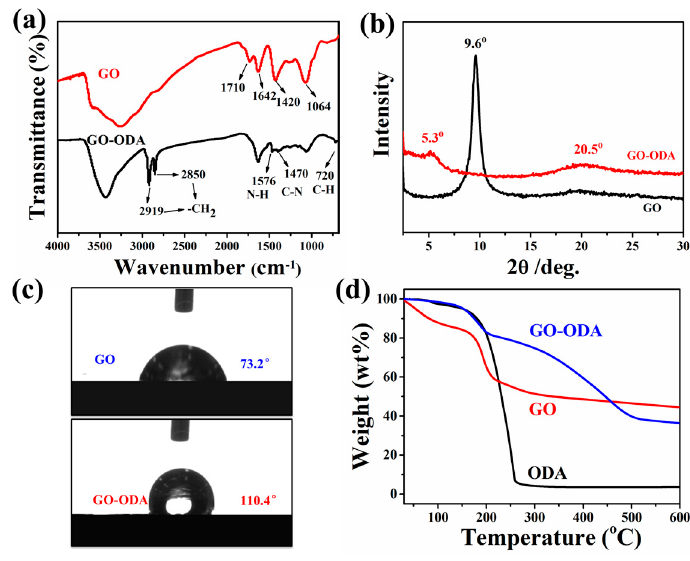
Figure 2. ( a ) Fourier-transform infrared spectroscopy (FTIR) spectra of graphene oxide (GO) and octadecylamine-grafted GO (GO–ODA); ( b ) X-ray diffraction (XRD) patterns of GO and GO–ODA; ( c ) Surface water contact angle of GO and GO–ODA. (d) TGA curves of ODA, GO and GO–ODA.